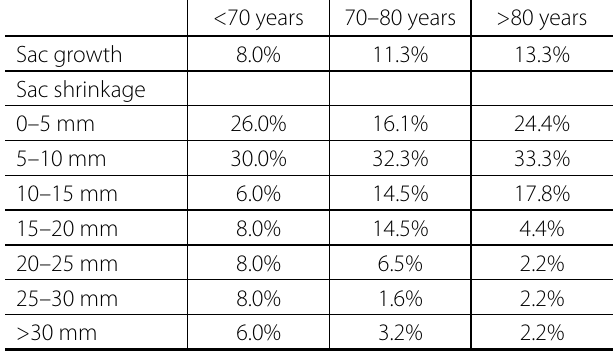
Table 6. Aneuysmal sac behavior after